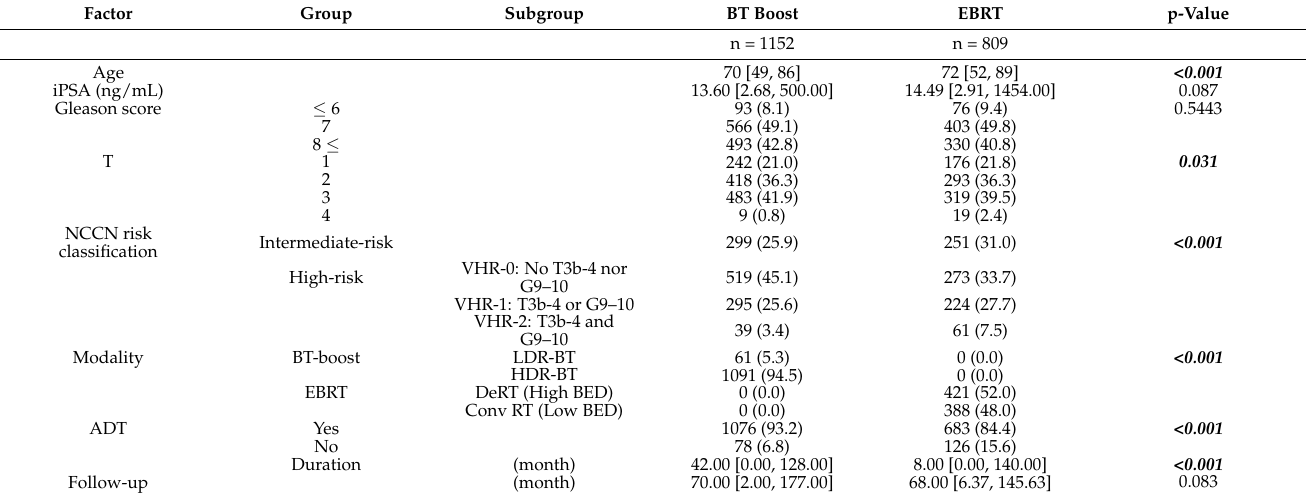
Table 1. Patients’